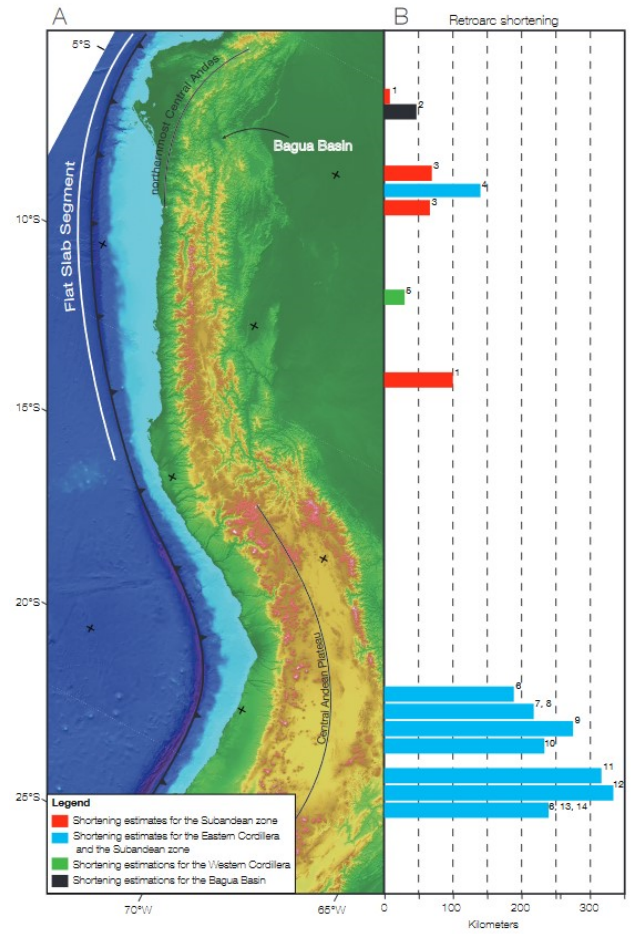
Figure 7. ( A ) Digital elevation model of the Central Andes and relevant morphotectonic features. ( B ) Retro-arc shortening estimations for the Central Andes, adapted from Horton (2018) [103]. References in figure are: (1) Gil Rodriguez et al., (2001) [99], (2) Baca Alvarez (2004) [101], (3) Calderon et al., (2017) [29], (4) Eude et al., (2015) [7], (5) Scherrenberg et al., (2014) [102], (6) Baby et al., (1997) [93], (7) Roeder (1988) [94], (8) Roeder and Chamberlain (1995) [95], (9) McQuarrie et al., (2008) [9], (10) Sheffels (1990) [97], (11) McQuarrie (2002) [96], (12) Anderson et al., (2017) [98], (13) Kley (1996) [91], and (14) Kley et al., (1997) [92]. Blue bars represent shorten- ing estimates of combined Eastern Cordillera and Subandean zone; red bars represent shortening estimates for only the Subandean zone; green bars represent shortening estimations for the Western Cordillera (i.e., Marañon fold-thrust belt); and black bars represent shortening estimation for the Bagua